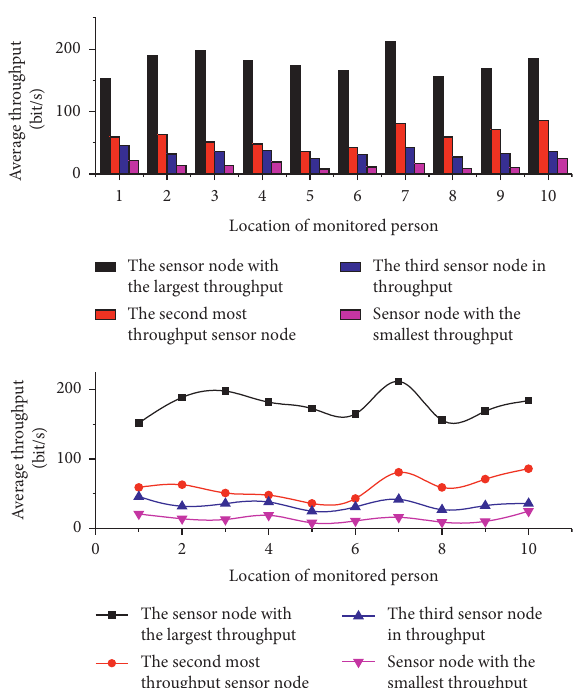
Figure 6: Total system throughput under the throughput maxi- mization mechanism and throughput of each sensor node under the throughput maximization